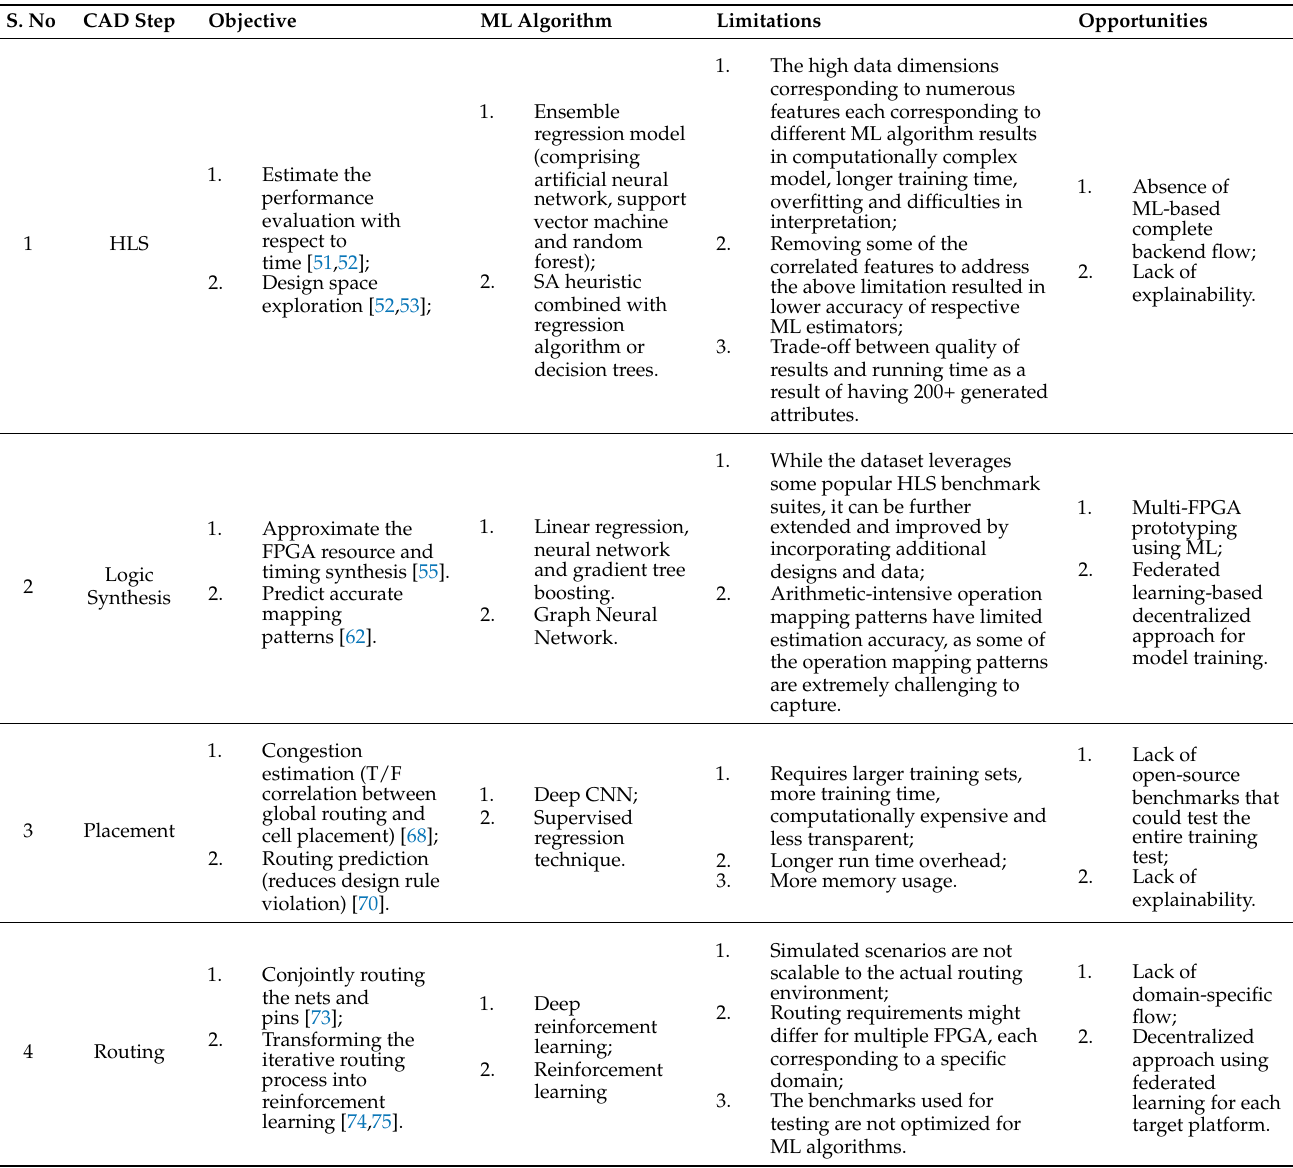
Table 1. Research opportunities identified to realize ML-based FPGA backend